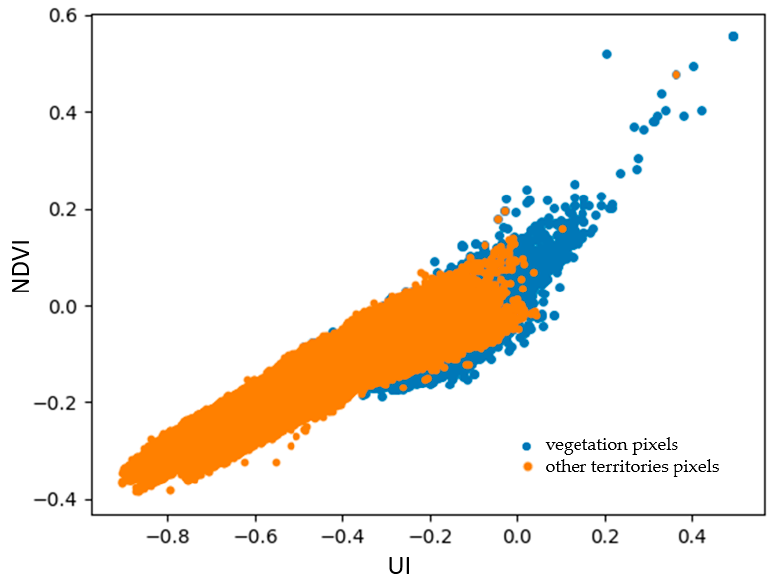
Figure 6. Scatter plots of land cover types in the Tomsk agglomeration in the spectral space of NDBI and UI.